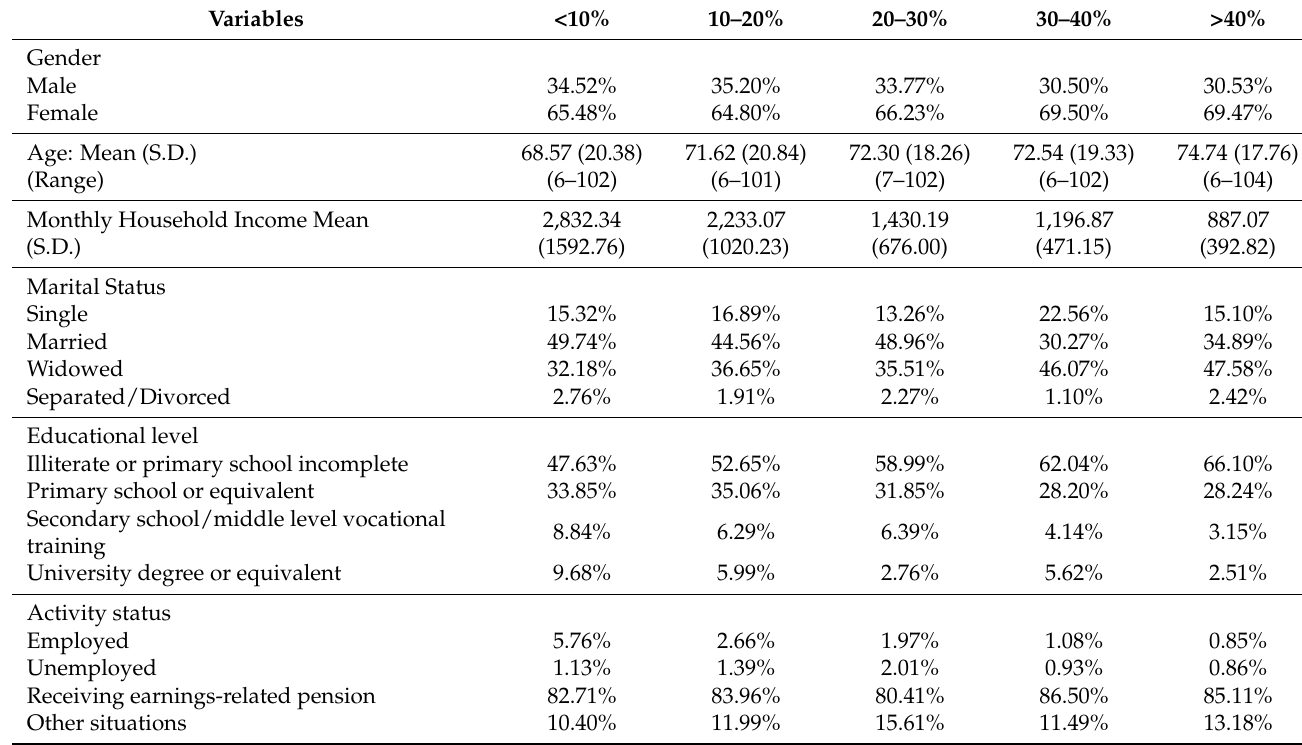
Table 2. Sociodemographic data of the sample, divided by values of catastrophe